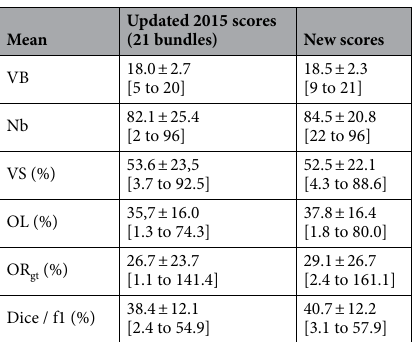
Table 2. Effect of the new segmentation on average scores. Nb: Number of submissions who recovered the bundle.